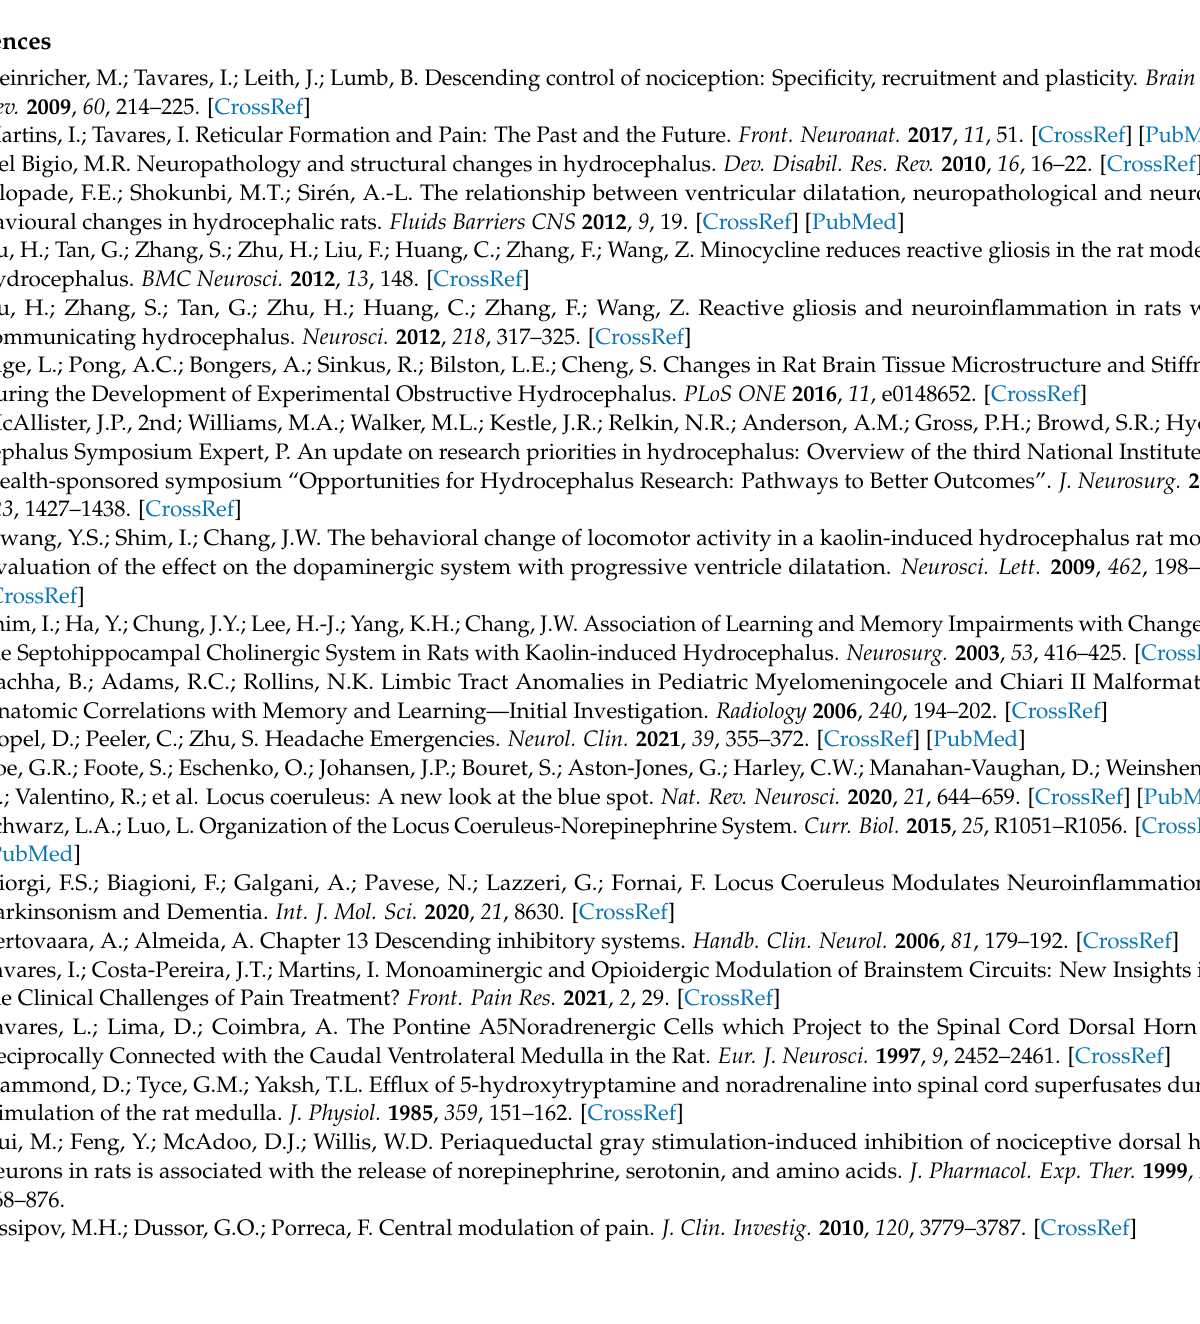
Figure A3. Nociceptive behavioral responses in the first and quiescent phases of the formalin test. Saline-injected (white bars) and kaolin-injected animals (grey bars) show similar pain behavioral scores, contrary to the second (inflammatory) phase of the test ( cf. Figure 5D). Saline n = 6; Kaolin n = 9. Data is as means ± SEM.